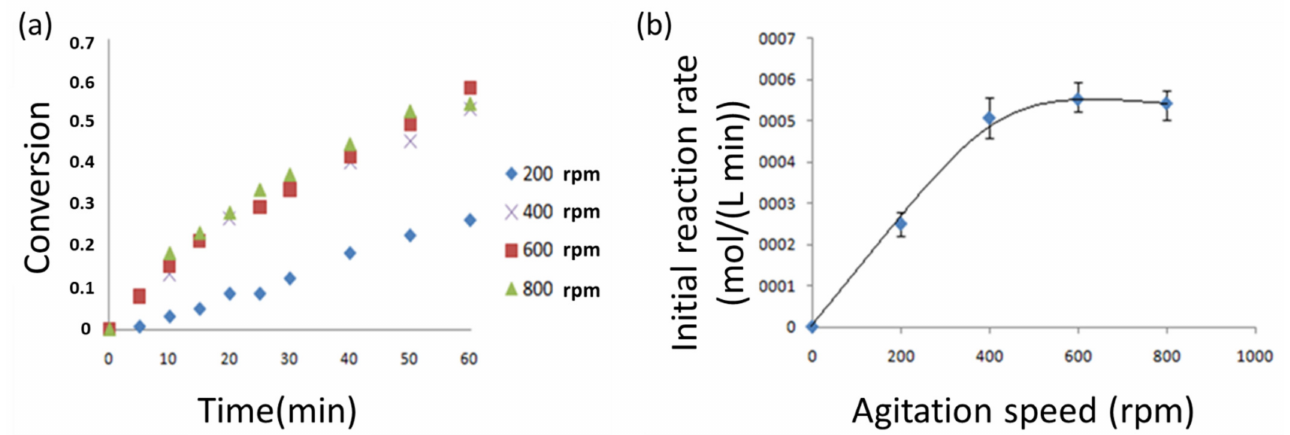
Figure 3. Effect of stirring speed on hydrolysis of cellobiose catalyzed by immobilized β -glucosidase (ASA-1000) at various reactor stirring speeds. Reaction conditions: 100 mg of immobilized RN8 deriva- tive; temperature 40 ◦ C; 2 mL sodium citrate buffer 100 mM pH 5.0; 20 g/L cellobiose. ( a ) Progress curves and ( b ) Initial observed rate versus agitation speed.